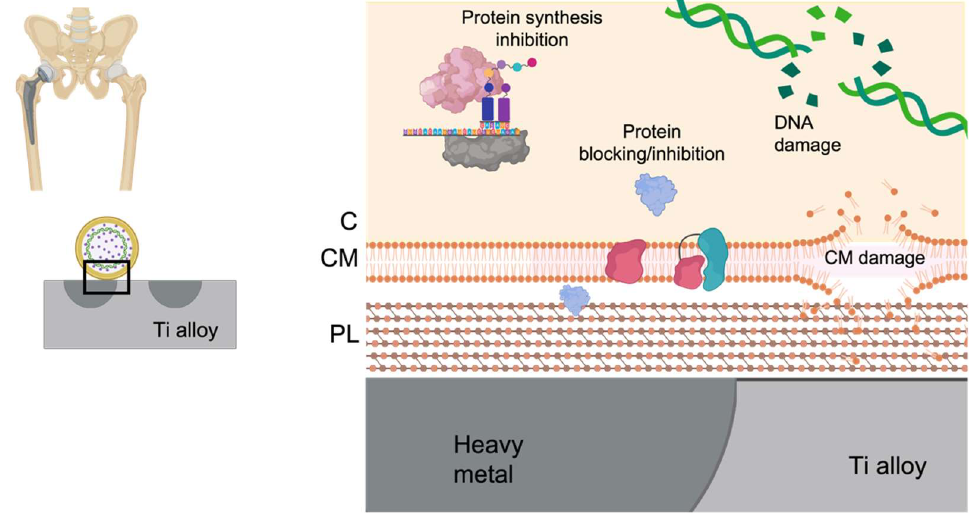
Figure 2. Main antibacterial mechanisms of heavy metals. PL: peptidoglycan layer. CM: cytoplas- matic membrane. C: cytoplasm.